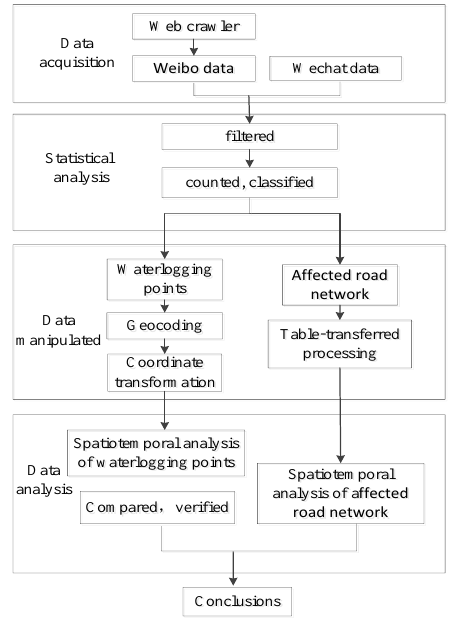
Figure 1. The framework of